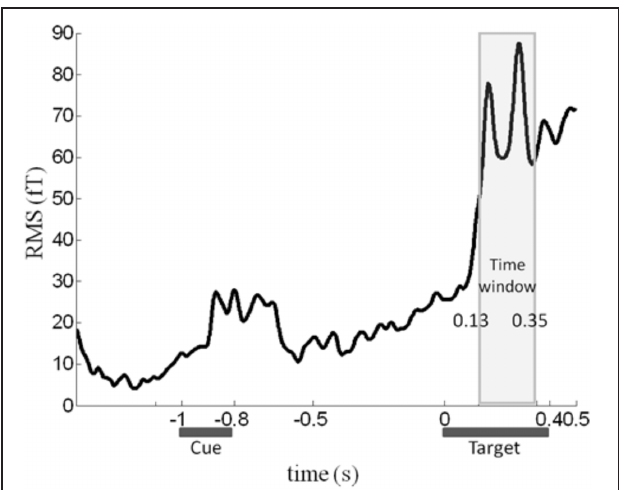
FIGURE 2 | Time course of the MEG signal. Root-mean-square (RMS) of the evoked response averaged across all sensors, experimental conditions and subjects. We focused our analysis on the 130–350ms time window (light gray rectangle), in which a robust response to target onset can be observed.